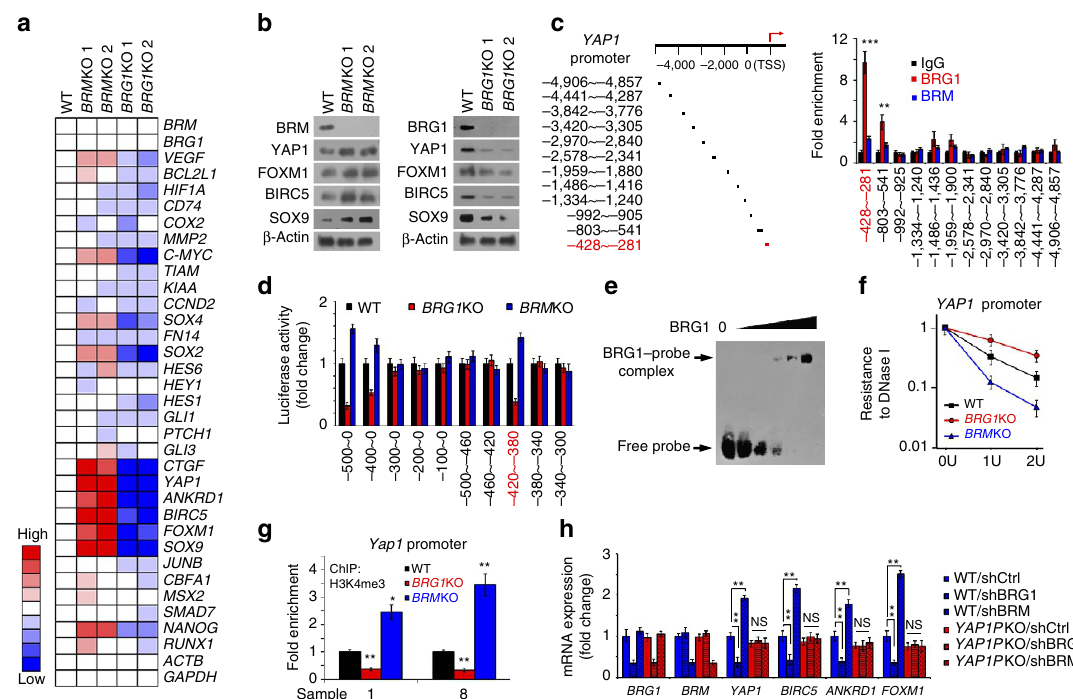
Figure 4 | BRG1-embedded BAF complex initiates YAP1 signalling in liver CSCs. ( a ) BRG1 and BRM KO cells were established by CRISPR/Cas9 approaches, followed by examination of main self-renewal pathway target genes. Gene fold changes were determined by RT–qPCR. CRISPR/Cas9 caused frameshift mutations with no changes in mRNA levels. ( b ) YAP1 targets were tested by immunoblotting in BRM KO spheres (left panel) or BRG1 KO spheres (right panel). ( c ) Schematic diagram of YAP1 promoter (left panel) and domain mapping (right panel). HCC primary spheres were collected for ChIP assay with BRG1, BRM antibodies. TSS, transcription start site. ( d ) The binding region of YAP1 promoter to BRG1 was validated by luciferase assay. ( e ) Biotin-labelled YAP1 promoter region ( (cid:2) 420 B (cid:2) 380bp) was used for EMSA assay. BRG1 was immunoprecipitated from Huh7 spheres using BRG1-specific antibody. ( f ) Oncosphere nuclear lysates of the indicated cells were treated with DNase I, followed by real-time PCR. ( g ) BRG1 KO or BRM KO spheres were used for ChIP assays using H3K4me3 antibody. ( h ) BRG1-binding region of YAP1 promoter was deleted in HCC primary tumour cells using CRISPR/Cas9 technology, followed by depletion of BRG1 or BRM . Total RNA was extracted for PCR assay. YAP1 PKO, YAP1 promoter KO. Data are shown as means ± s.d. Two tailed Student’s t -test was used for statistical analysis; * P o 0.05 and ** P o 0.01; NS, not significant. Data are representative of three independent